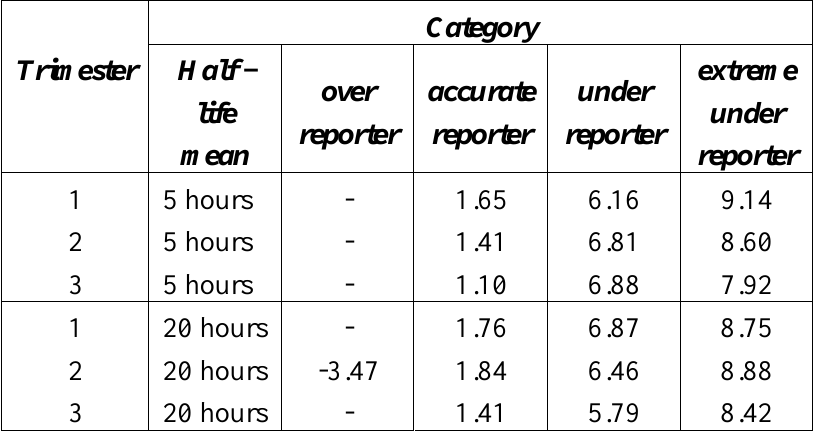
Table 5. The average numbers of adjusted cigarettes in each category over trimesters, under different values of cotinine half-life.